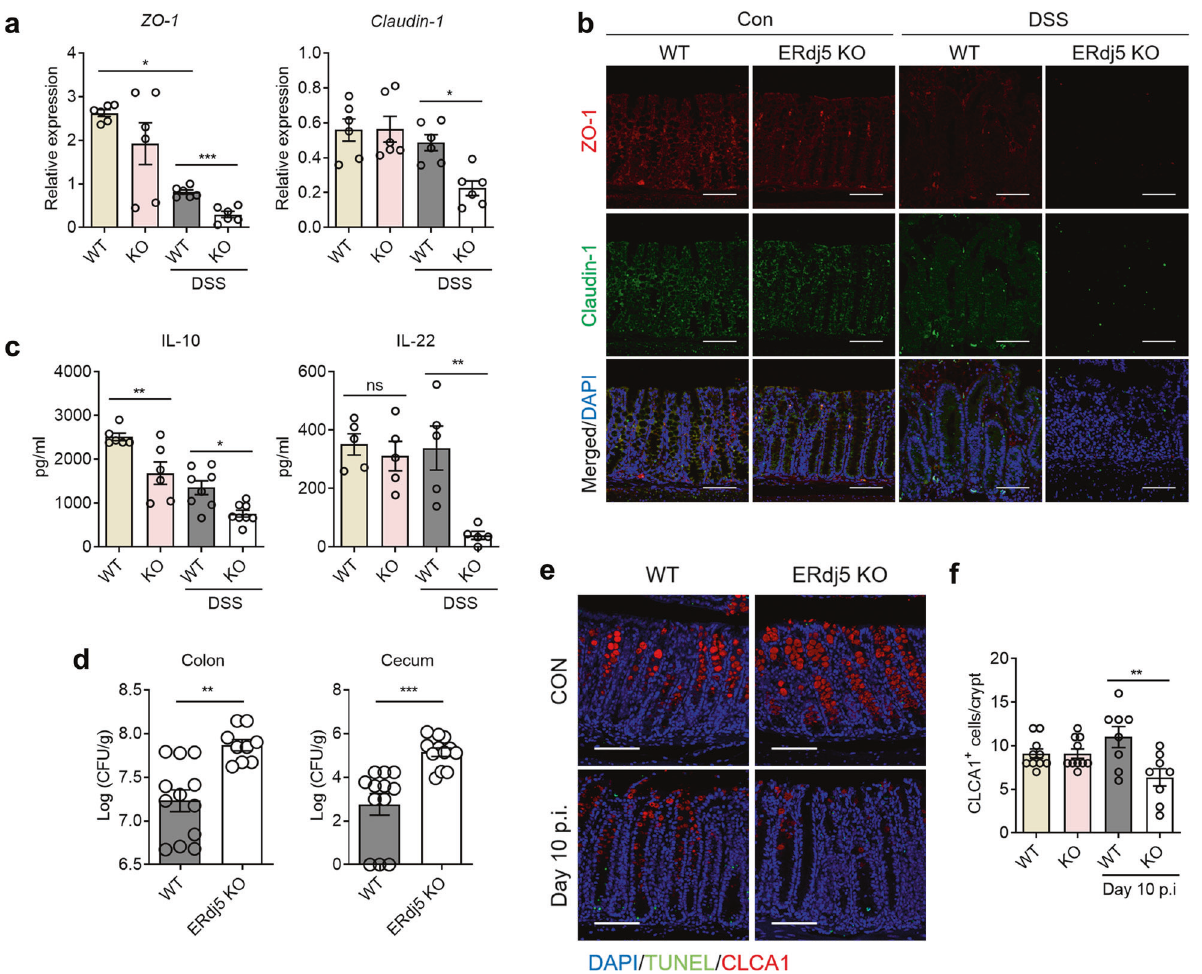
Fig. 4 ERdj5 contributes to the maintenance of intestinal barrier integrity. a Zo-1 and Cldn1 mRNA expression in the colon tissues of WT or ERdj5- KO mice treated with DSS ( n = 6 per group). b Immuno fl uorescence images of colon tissue stained for the tight junction proteins ZO-1 (red) and Claudin-1 (green) (×200, scale bar 100 µm). c IL-10 and IL-22 expression in colon tissue homogenates ( n = 5 – 8 per group). d Mice were infected with 2.5 × 10 8 CFU of C. rodentium . On Day 14 postinfection, CFUs in the colon and cecum were measured ( n = 9 – 12 per